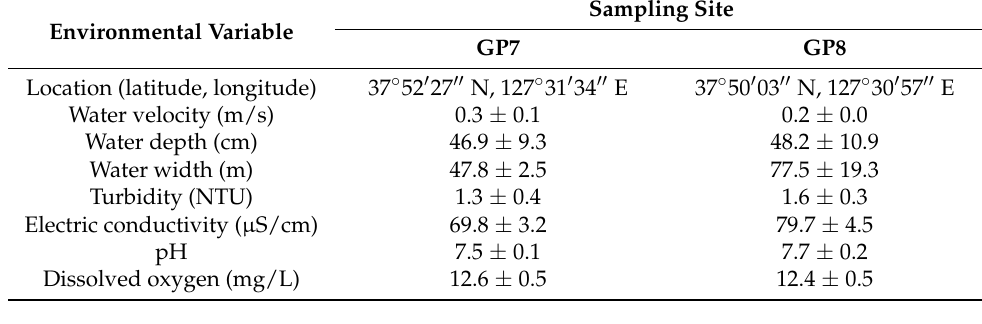
Table 1. Environmental characteristics (mean ± standard error) at sampling sites.